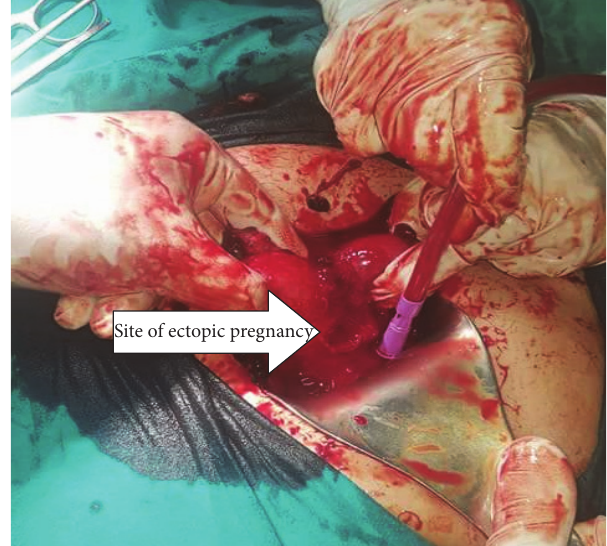
Figure 2: Laparotomy with bicornuate uterus and site of ectopic pregnancy arrow.